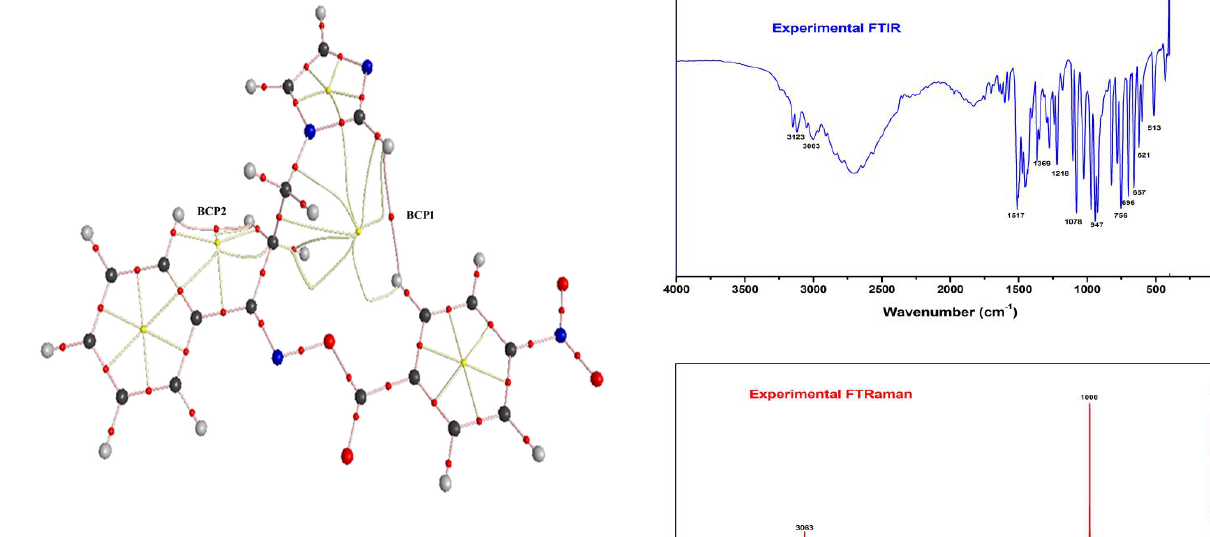
Figure 9: Simulated FT-IR and FT-Raman and spectra of the IPAONM molecule.